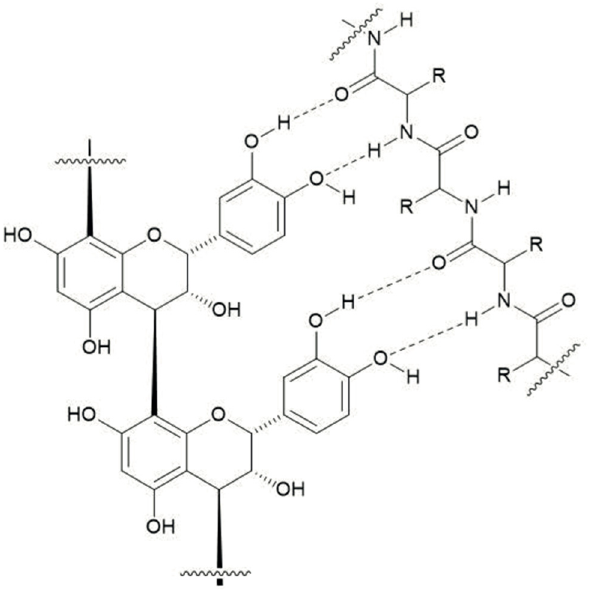
Figure 2. Hydrogen bonding involved in condensed tannin–protein complexation. Reproduced with permission from Zeller [83], Crop Science; published by John Wiley & Sons, 2019. permission from Zeller [83], Crop Science; published by John Wiley & Sons,